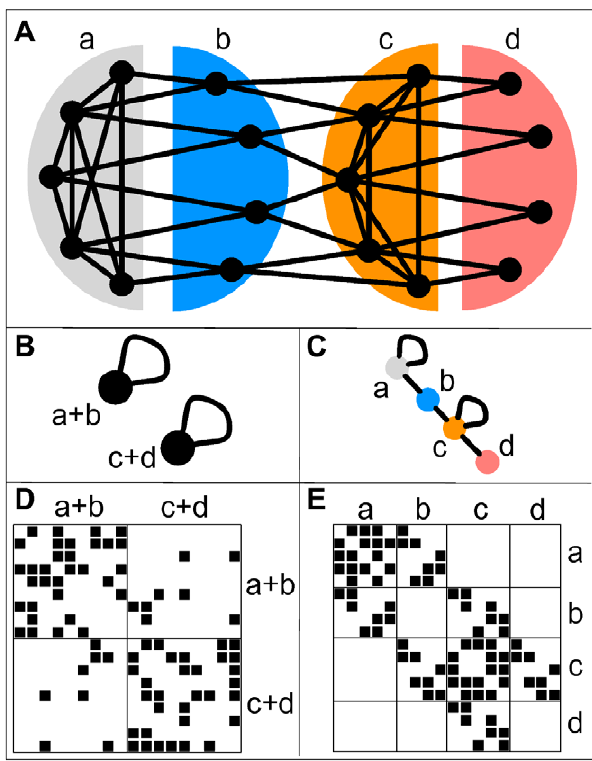
Figure 1. An example network and possible image graphs. A A simple example network of nodes of 4 different types identified by their structural position. Nodes of types a and c are densely connected among themselves. The nodes of type b have connections to both nodes of types a and c , but not among themselves, i.e. they mediate between types a and c . The nodes of type d only have connections to nodes of type c , but not among each other, i.e. they form a periphery to type c nodes. B and C Two possible image graphs for the functional understanding of this network show the connections among groups of nodes. A typical network clustering will aggregate nodes into clusters densely connected internally but only sparsely connected to the rest, as depicted in the left image graph. This will result in grouping nodes of types a and b together and nodes of type c and d together. Because of aggregating nodes into cohesive groups, any such algorithm will never recognize nodes of type c and d as different and hence miss essential part of the network’s structure. On the opposite, the right image graph correctly captures the network structure of the 4 different types as the 4 different nodes in the image graph. D and E The adjacency matrices of our example network with rows and columns ordered according to the two decompositions shown above. A black square in position ( i , j ) indicates the existence of a link connecting node i with node j . Rows and columns are ordered such that nodes in the same group are adjacent. The internal order of the nodes in the groups is random. Each block in the matrix corresponds to a possible edge in the image graph. The left matrix shows the adjacency matrix for the output of a typical clustering algorithm which groups nodes of type a and b , as well as c and d together. Clearly, we see dense blocks along the diagonal and sparse blocks on the off-diagonal of the matrix as expected. The right matrix depicts the adjacency matrix with rows and columns according to the actual types of the nodes. All empty blocks in this matrix correspond to a missing edge in the image graph and all populated blocks are represented by an edge in the image graph. We see that for this network, the image graph perfectly captures the structure of the